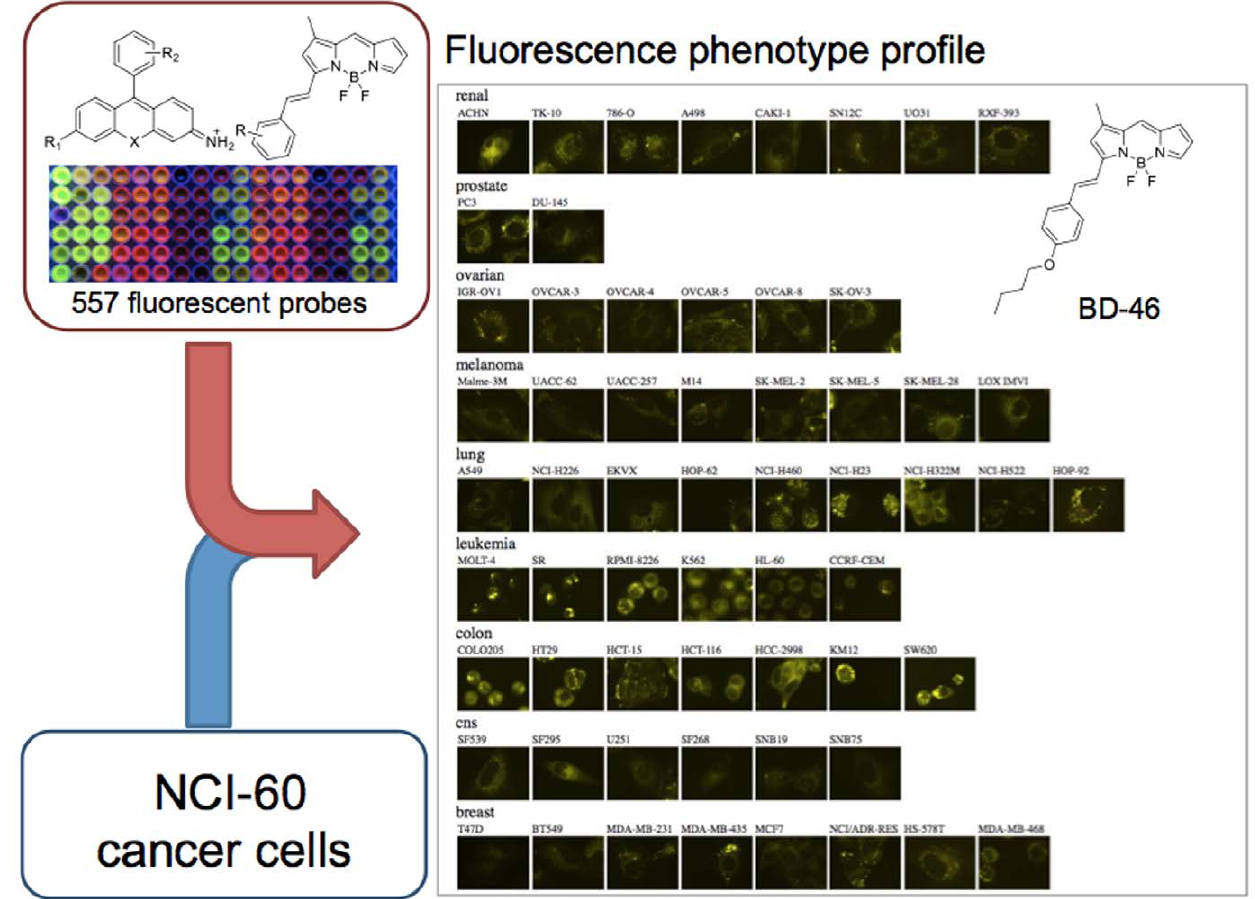
Figure 1. Fluorescence phenotype profiling workflow and representative fluorescence phenotype profile; BD-46 (500 nM) was added to 60 human cancer cell-lines and fluorescence phenotype profiles were measured after 1 h using automated fluorescence microscopy.